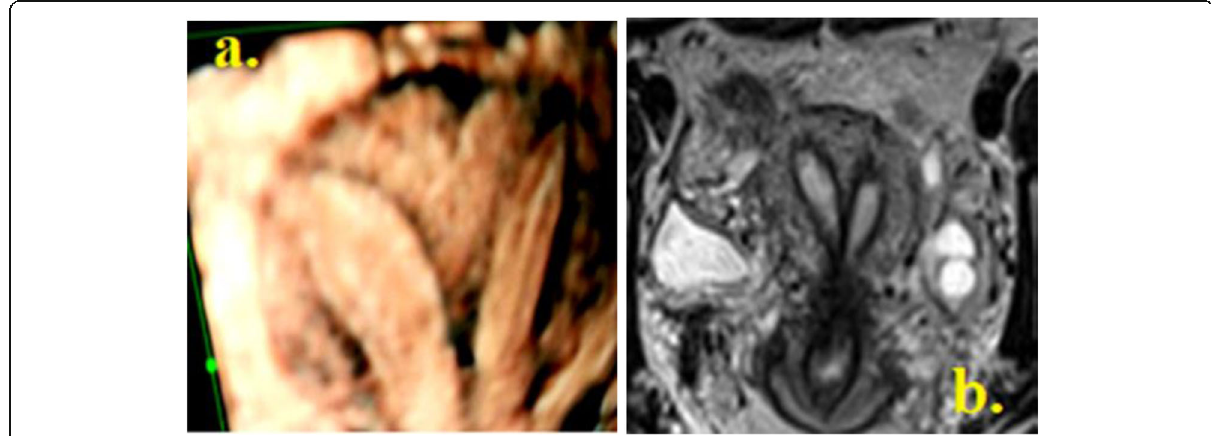
Fig. 6 A 21-year-old married female patient, complaining of primary infertility. a Partial septate uterus (class U2A) by 3DTVS showing straight fundal outline and the septum seen dividing uterine cavity into two equal uterine cavities. b MRI coronal T2WI showing the same findings